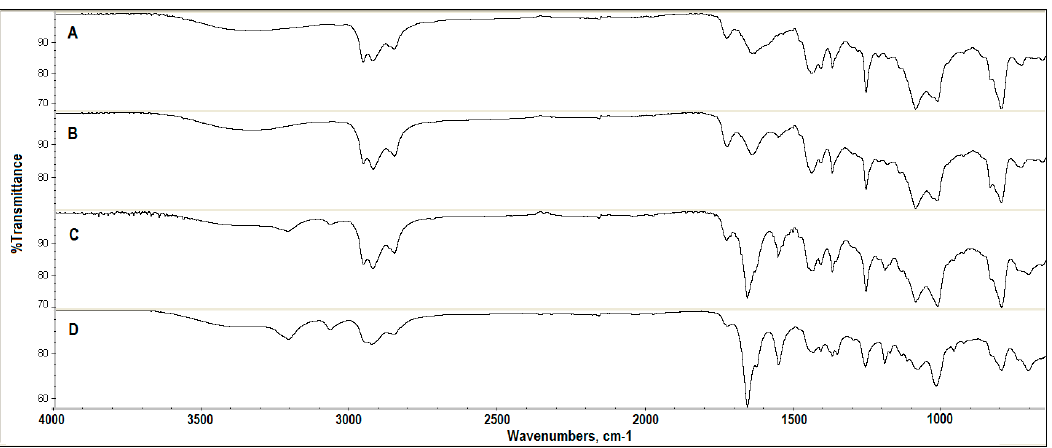
Figure 7. FTIR spectra of the siliconized latex catheter recorded during multi-stage modification